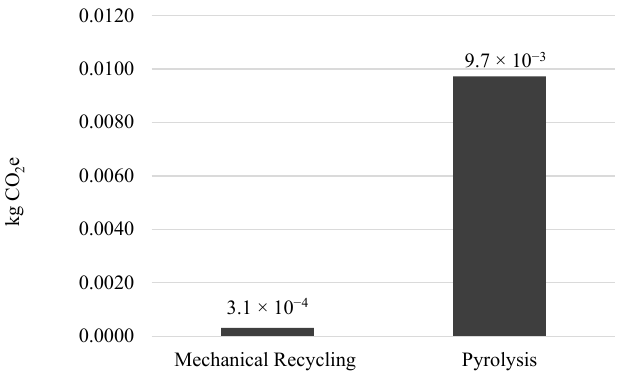
Figure 3. Global warming potential in kg CO 2 e of 1 kg re-usable material out of a double wall— recycling phase 2.